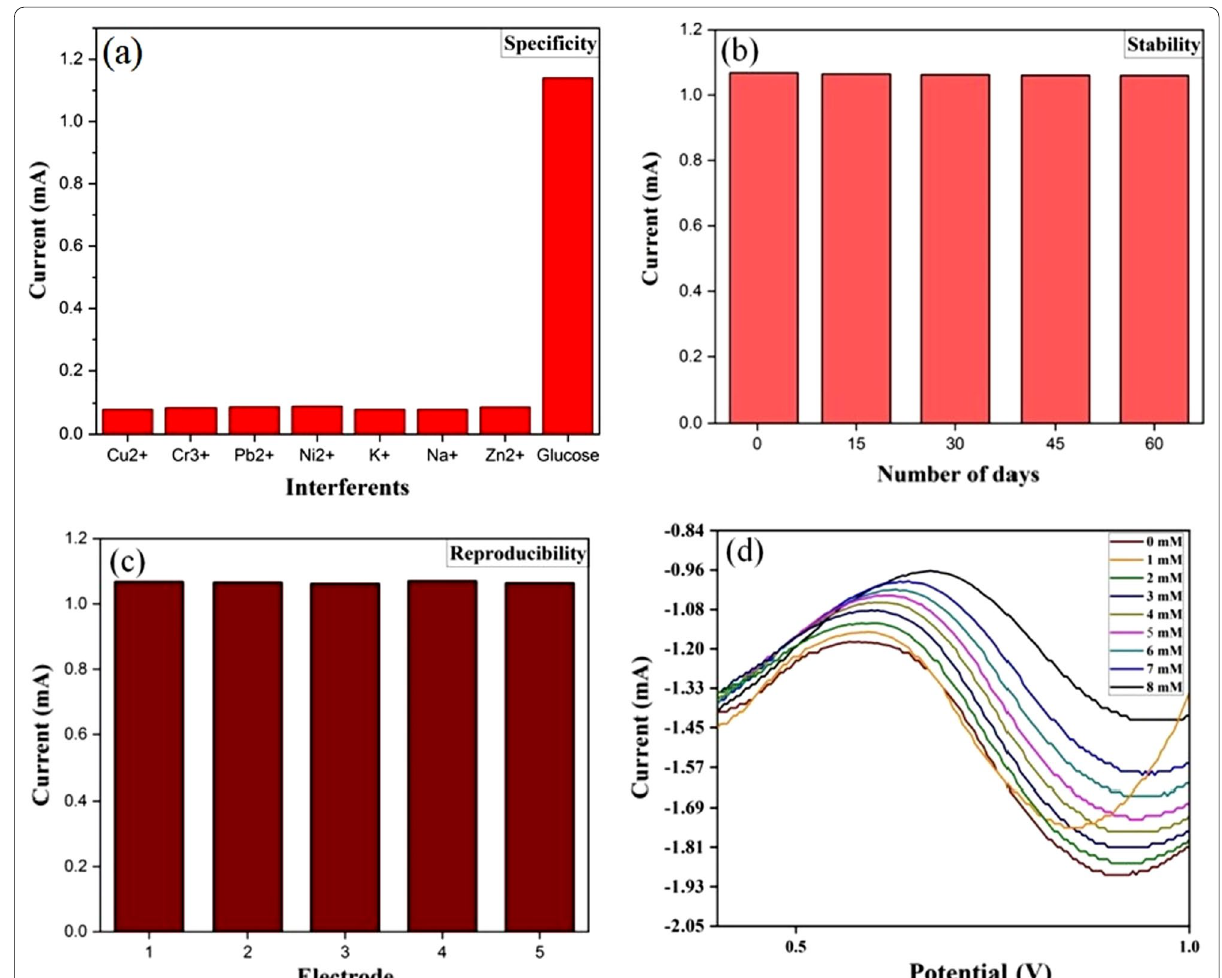
Fig. 7 a Specificity b stability and c reproducibility of cotton/ppy/Cu/Cu–Mn modified electrode, d detection of glucose from the sample of human